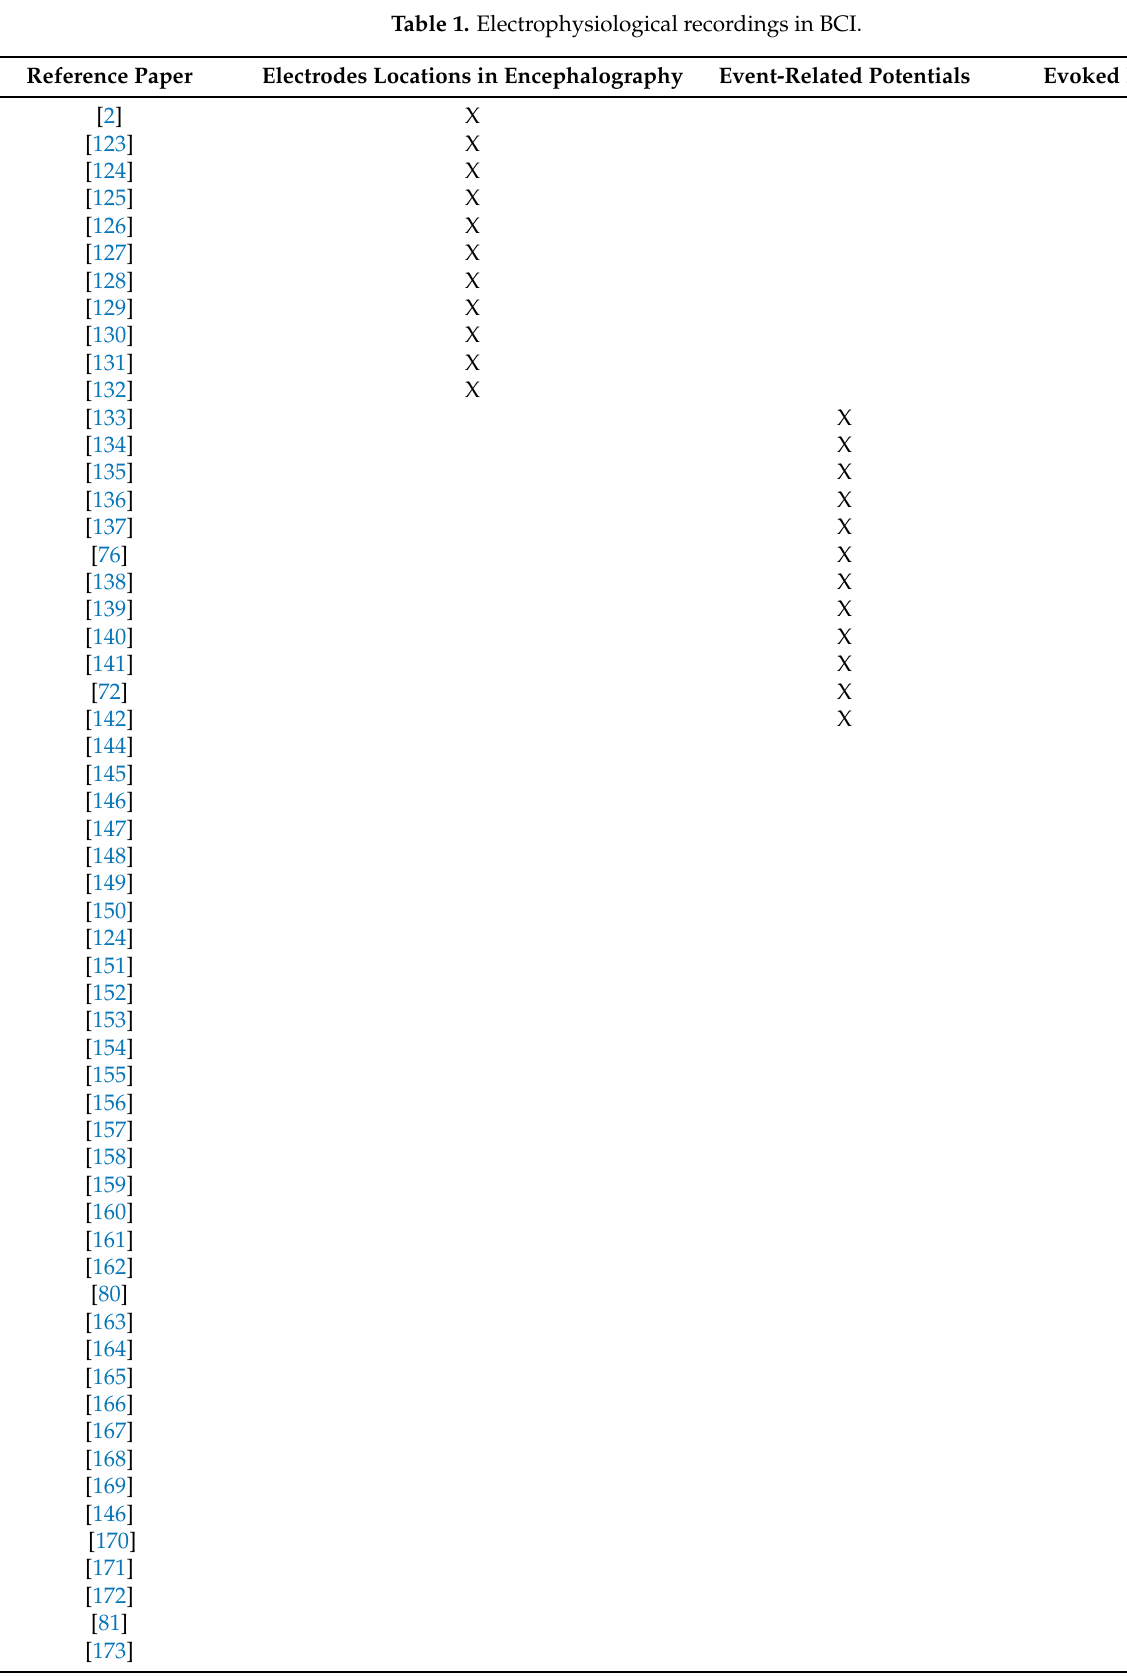
Table 1. Electrophysiological recordings in